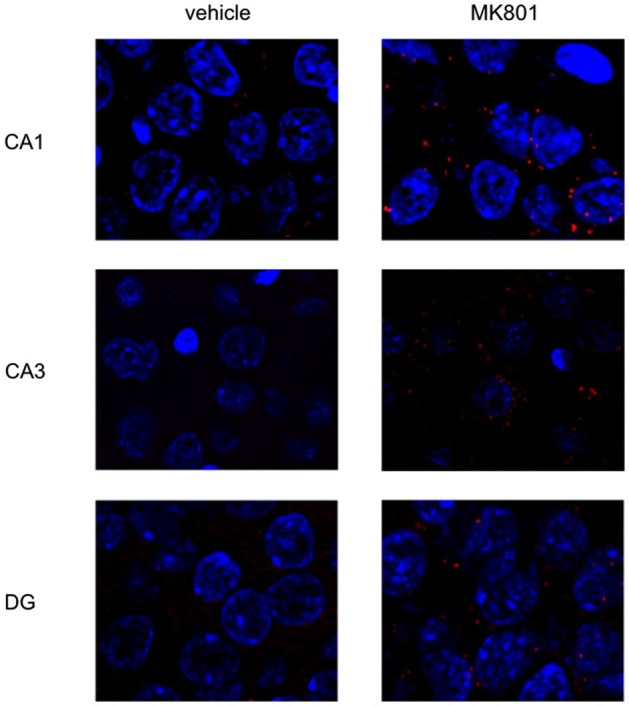
MK801-treatment alters basal Arc gene expression in the hippocampus. Spatial learning elicits increases in Arc expression in control, but not MK801-treated animals. The images show Arc expression (red dots) in the CA1 and CA3 regions and dentate gyrus (DG), in naïve animals, after vehicle (left images) or MK801 injection (right images). MK801-treated animals exhibit a significantly higher basal Arc expression in the CA1 and CA3 regions compared to vehicle-treated animals. The nuclei were stained in blue using DAPI. The pictures were taken using a 63× objective.